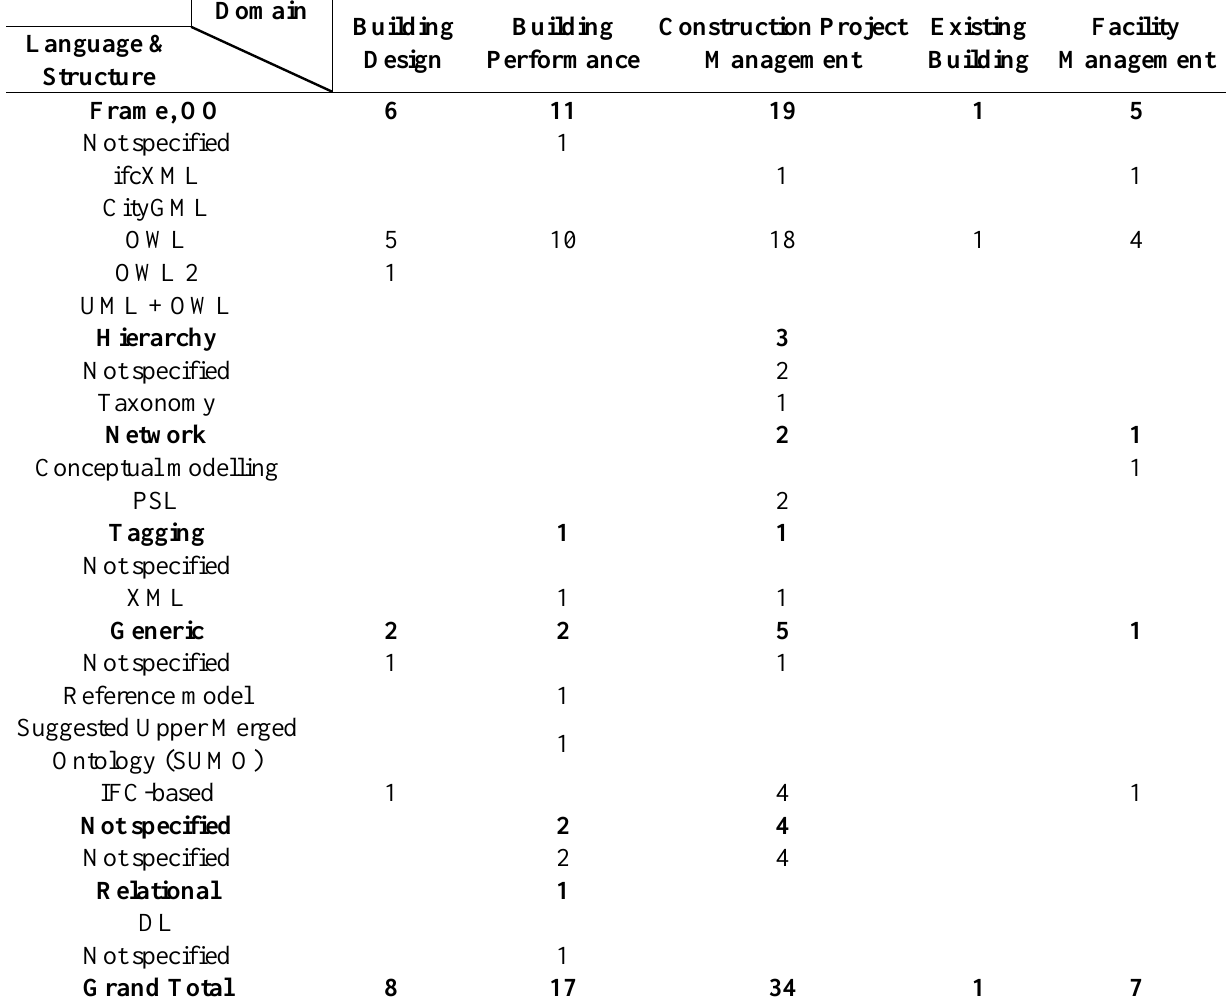
Table 2. Ontology languages in different built